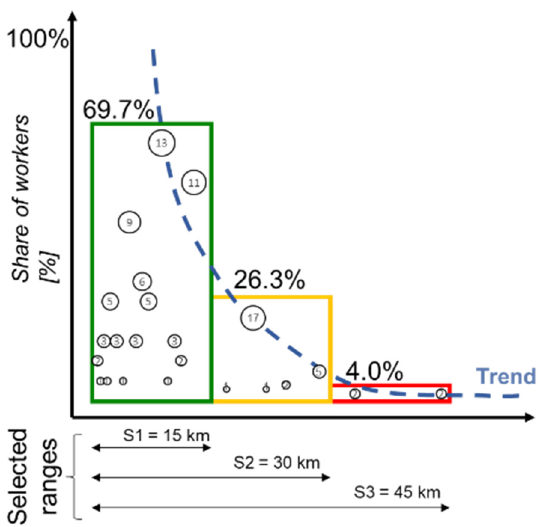
Figure 2. Average travel distance (km) questionnaire among people using the nZEB building in Poznan University of Technology complex (own survey).